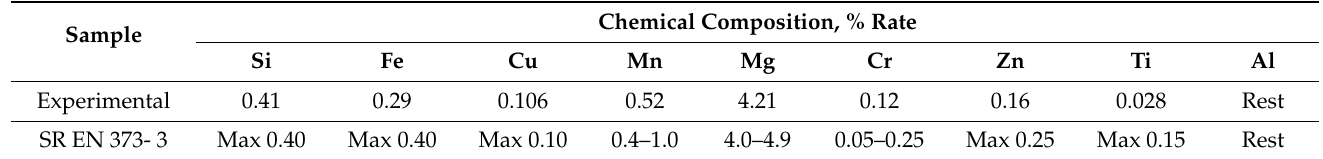
Table 1. Chemical composition of experimental alloy specimens